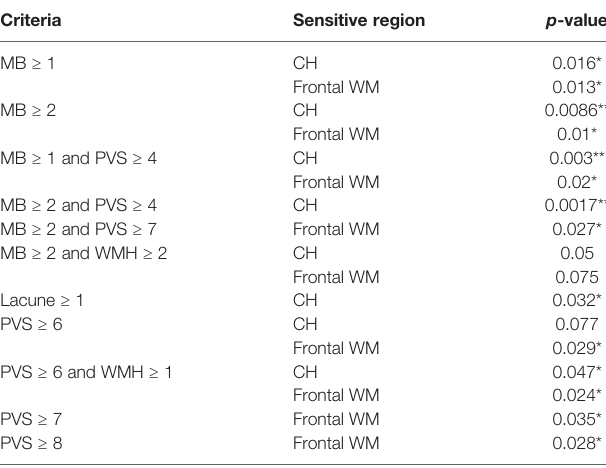
TABLE 4 | Statistical power of various combinations of CSVD items in determining the K trans in nondiabetes group. Criteria Sensitive region p